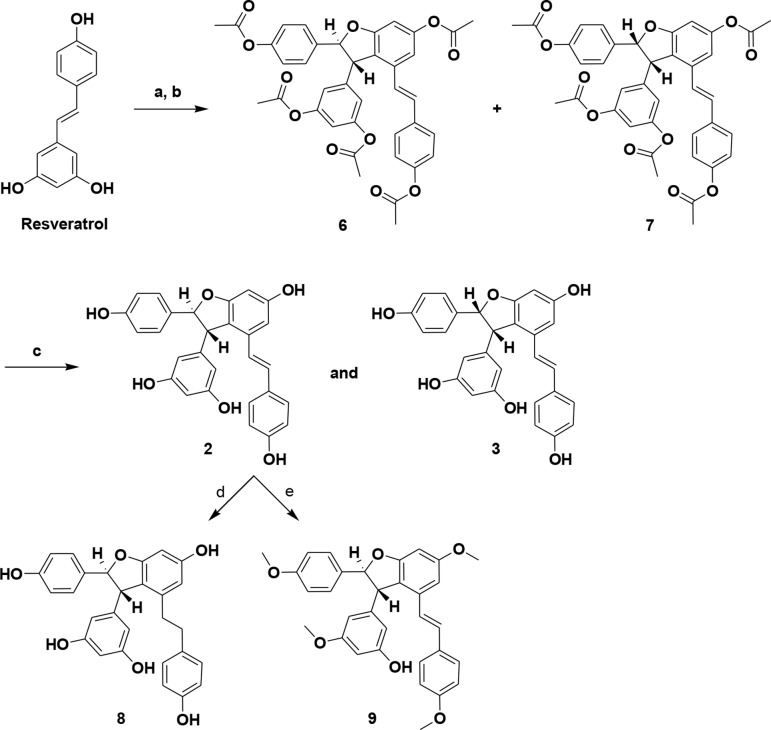
Synthesis of (±)-ε-viniferin (2), (±)-(E)-ω-viniferin (3), 8, and 9. (a) RuCl3·H2O, MeOH, water, 0°C to 35°C, 3 h; (b) (Ac)2O, TEA, MC, DMSO, 0°C to RT, 5 h; (c) KOH, MeOH, RT; (d) 10% Pd/C, H2, EtOH, RT, 3 h; (e) MeI, K2CO3, acetone, 65°C, 6 h.